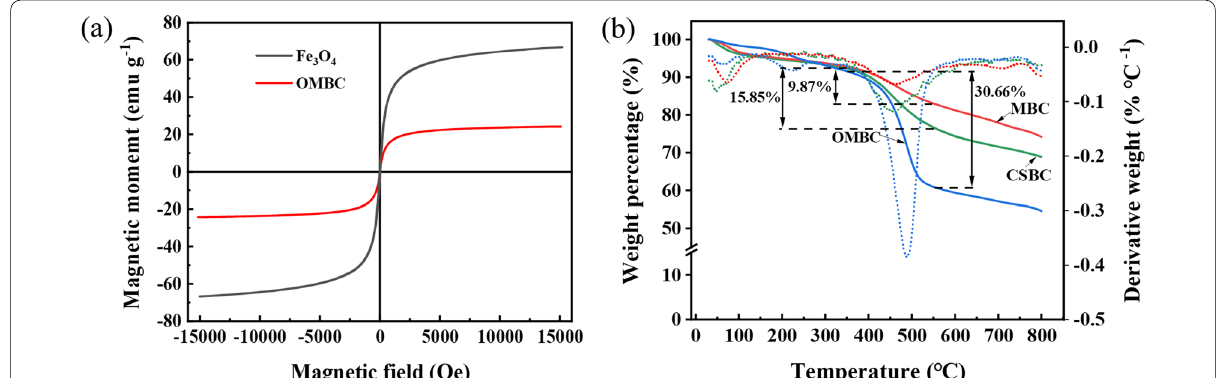
Fig. 5 Magnetic hysteresis loop of magnetic Fe 3 O 4 and OMBC ( a ). Thermogravimetric analysis curves (10 ℃ min − 1 heating rate under N 2 atmosphere) of CSBC (350 ℃ ), MBC, and OMBC ( b